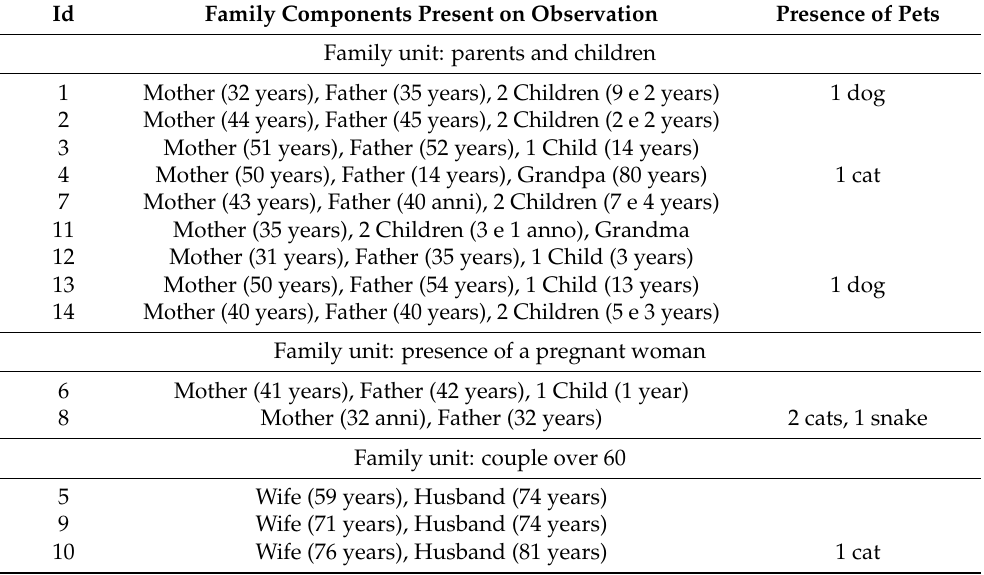
Table 1. Characteristics of the observed sample. Id Family Components Present on Observation Presence of Pets Family unit: parents and